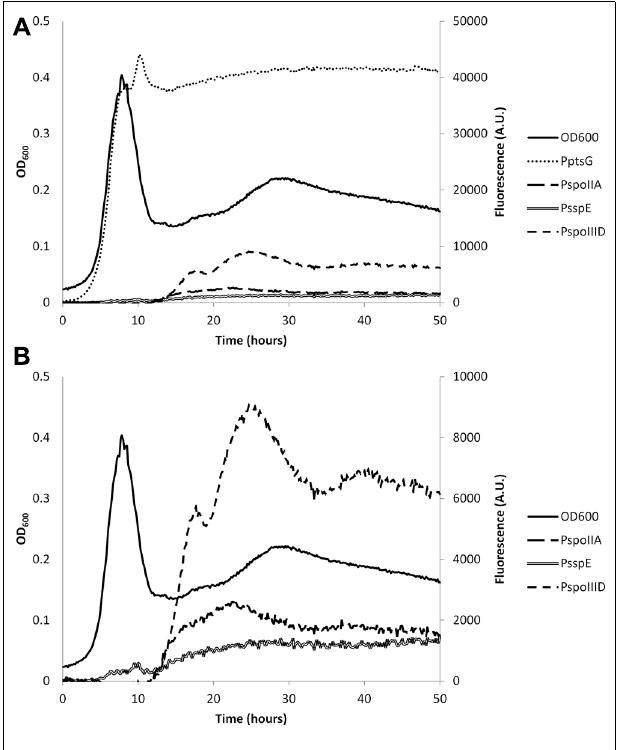
FIGURE 3 | Representative example of the expression levels of IpHluorin from different promoters during different growth stages. (A) Fluorescence levels from excitation at 390 nm and emission at 510 nm from different promoters used. (B) Identical to (A) , but without P ptsG -IpHluorin. Expression of IpHluorin from sporulation-specific promoters starts only after the drop in OD 600 .